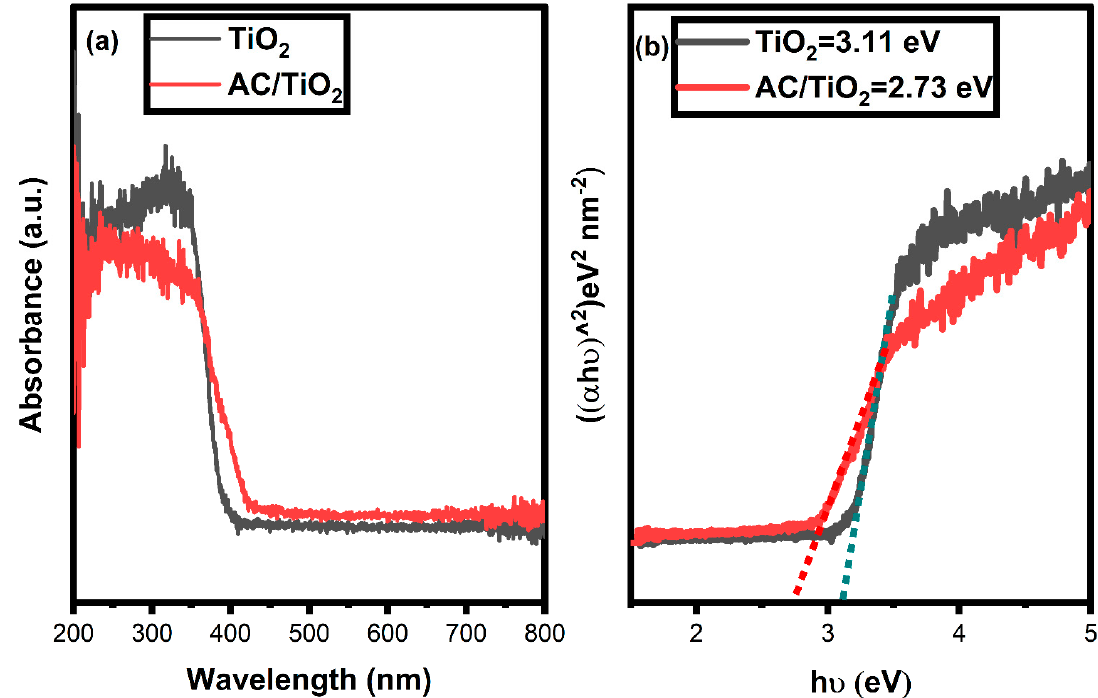
Figure 3. UV-DRS absorbance ( a ) and bandgap spectrum ( b ) of TiO 2 and AC/TiO 2